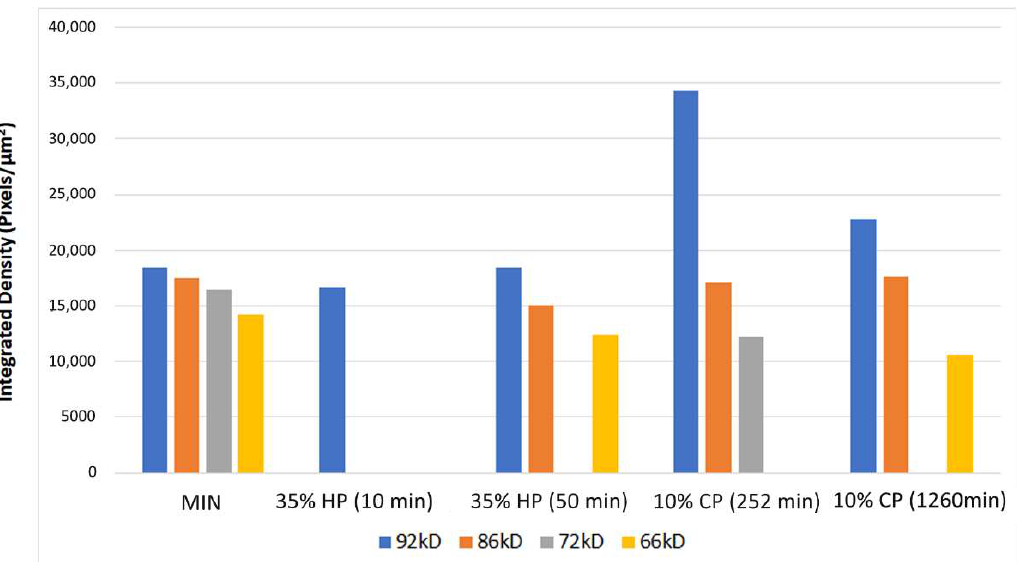
Figure 4. Graph illustrating the densitometric evaluation of bands obtained from the gelatin zymo- graphic analysis of proteins extracted from dentin powder; 92 kDa molecular weight corresponds to pro-MMP-9; 86 kDa molecular weight corresponds to the active form of MMP-9; 72 kDa molecular weight corresponds to pro-MMP-2; 66 kDa molecular weight corresponds to the active form of MMP-2. HP: hydrogen peroxide, CP: carbamide peroxide.